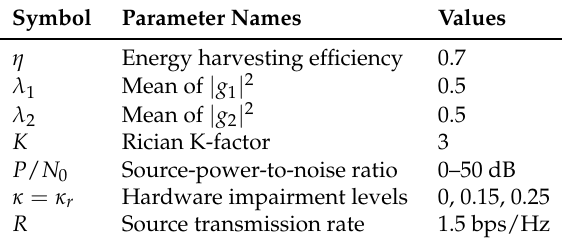
Table 1. Simulation parameters.